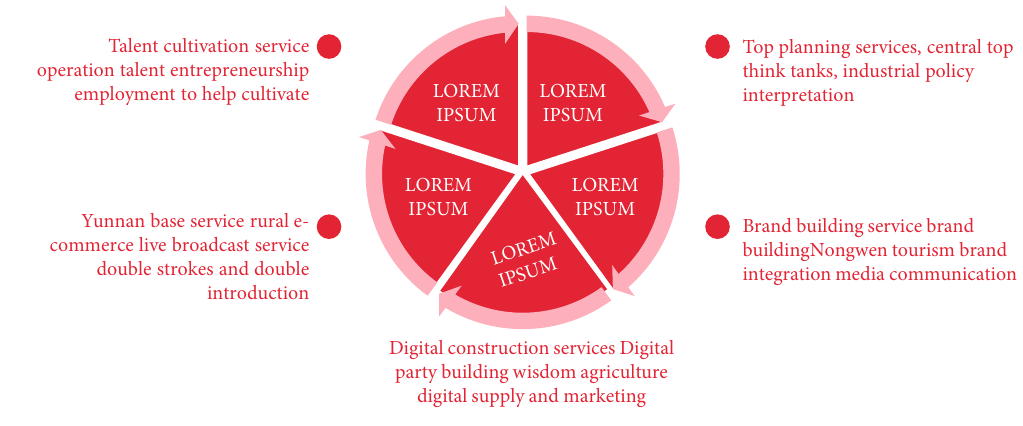
Figure 5: Digital rural revitalization 5-in-one service closed-loop ecosystem.